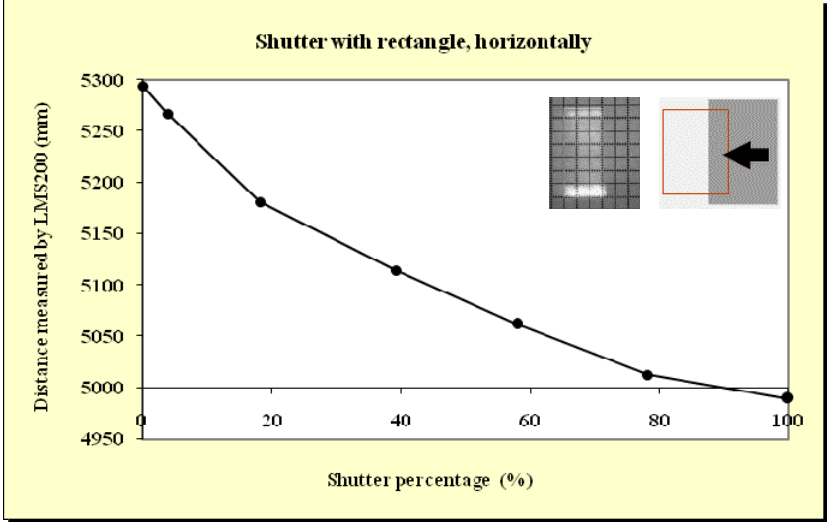
Figure 14. Graphic representation of the evolution of the distance measurement given by the sensor when the laser beam (90°) was incrementally blocked (from right to left) using the rectangular shaped template at a distance of 5 m from the sensor and the unblocked part of the beam was captured by the grid template at a distance of 5.3